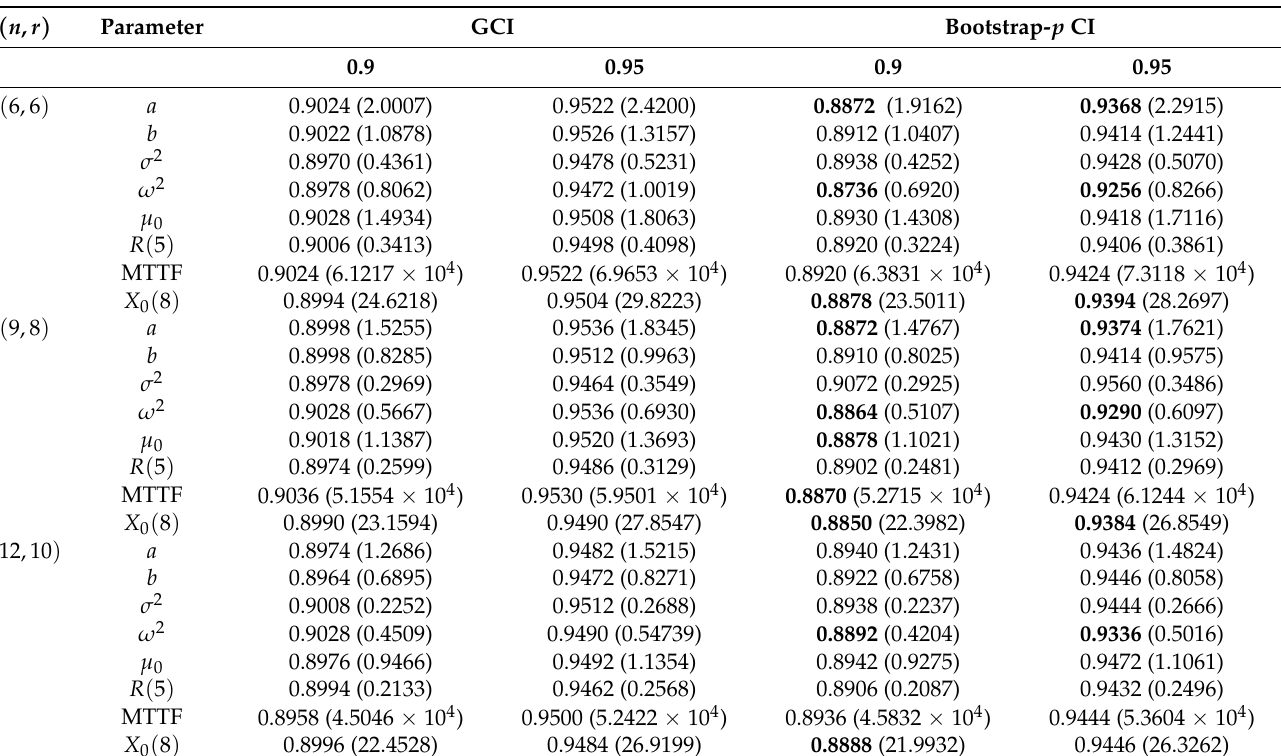
Table 4. The CPs and AILs (in parentheses) of different CIs under parameter setting I for nominal levels 0.9, 0.95, based on 5000